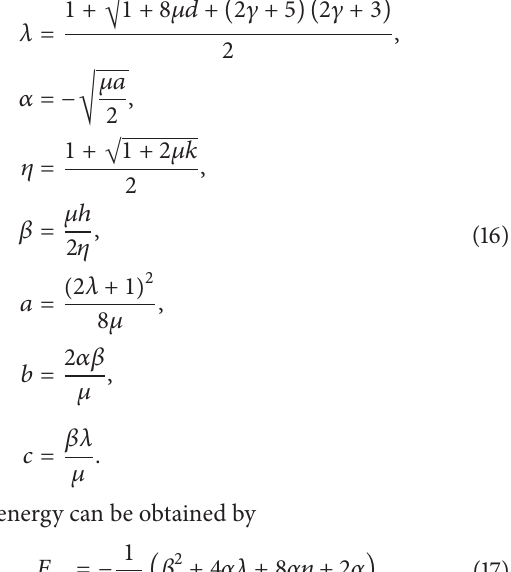
Table 1: Eigenvalues of 𝐶 2 [𝑆𝑈 SF (6)] and 𝐶 2 [𝑆𝑈 𝐹 (3)] Casimir